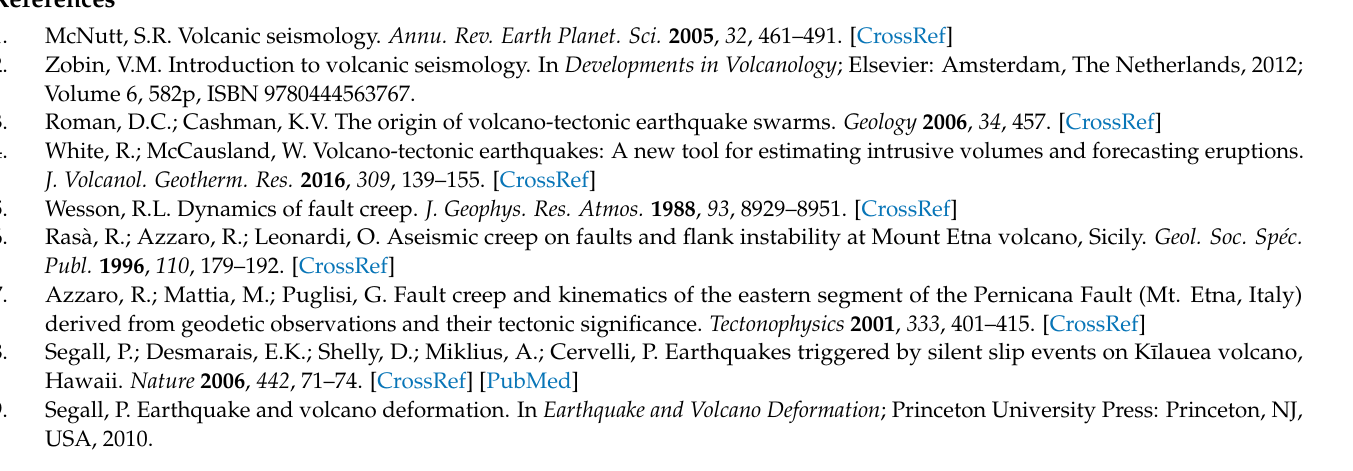
Supplementary Figure S4. Standard deviation for the velocity of the vertical ground motion as obtained from the analysis of DInSAR data, for the four time periods indicated in Table 1. (Figure 4). Supplementary Figure S5. Standard deviation for the difference (Figure 5) of the velocity of the vertical ground motion in the period immediately following the earthquake (POST period; Figure 4c) minus the velocity measured in the period preceding the event (PRE period; Figure 4b). Supplementary Table S1. Historical seismicity in the island of Ischia (after [27] and [24]). Epicentral intensity and magnitude values from CPTI15 [23] are reported in parentheses. *uncertain